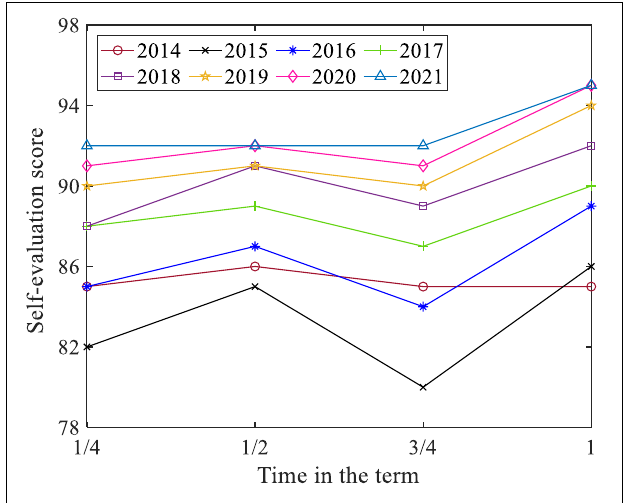
FIGURE 6 | Student self-evaluation in